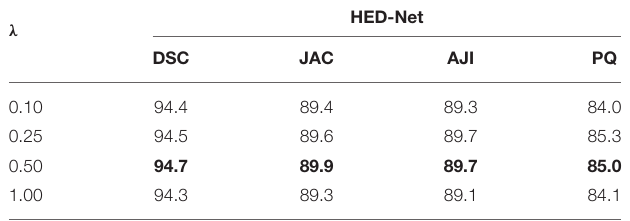
TABLE 5 | The impact of the tradeoff parameter λ .